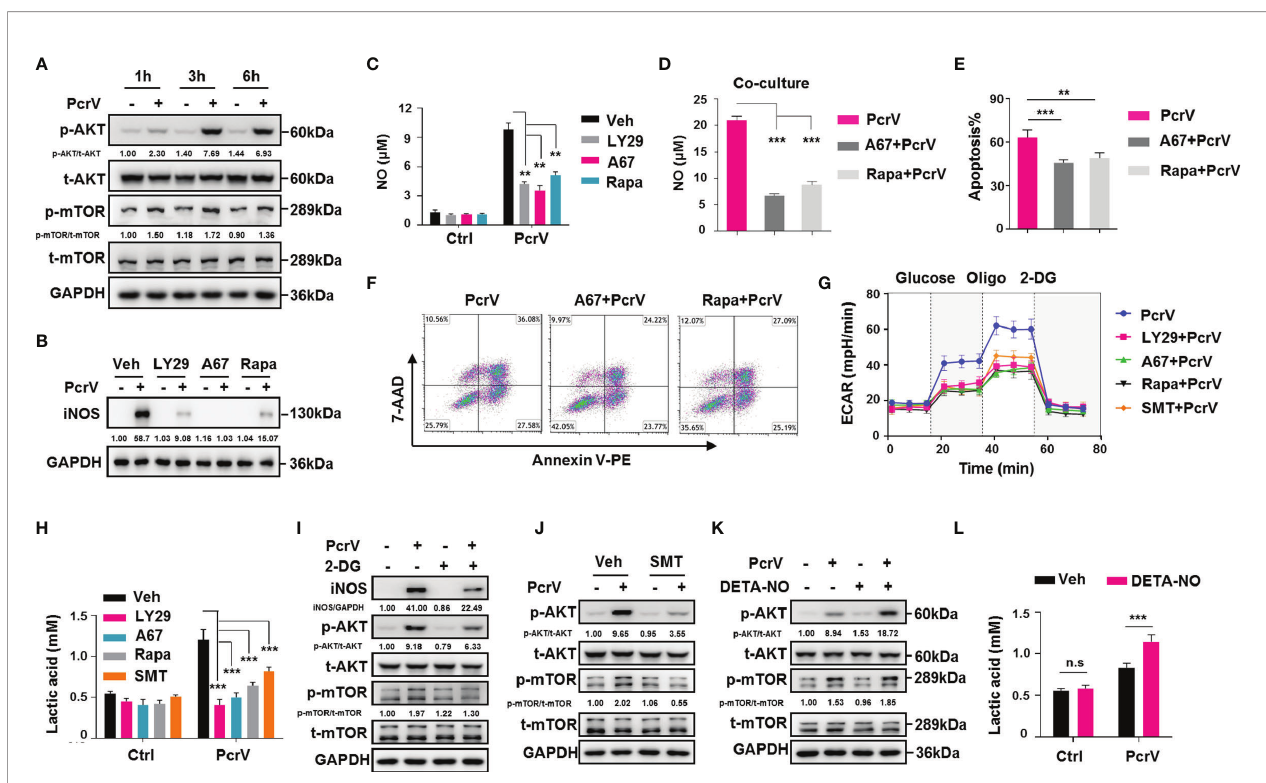
FIGURE 6 | PcrV-mediated activation of the PI3K/AKT/mTOR-glycolysis-NO feedback loop reeducates tumor-associated macrophage (TAMs) and enhances TAM- mediated cytotoxicity against cancer cells. For the inhibition of the PI3K/AKT/mTOR axis, TAMs were pretreated with a PI3K (LY294002, 20 m M), AKT (A674563, 1 m M), or mTOR (rapamycin, 50 m M) inhibitor for 1 h and then primed with PcrV (10 m g/ml) for the indicated times. (A, B) Protein levels were analyzed by Western blotting. (C) The nitric oxide (NO) level in the culture supernatant (24 h) was detected using Griess reagent. Bone marrow-derived macrophages (BMDMs) pretreated with AKT or mTOR for 1 h were primed with PcrV (10 m g/ml) for 24 h and then co-cultured with LLC cells for another 24 h (D) Detection of NO levels in the culture medium. (E, F) The apoptosis of LLC cells was detected by FACS. TAMs pretreated with the PI3K/AKT/mTOR inhibitors (1 h), S -methyl thiourea (SMT; 0.5 mM, 2 h), or 2-deoxy- D -glucose (2-DG; 2 mM, 2 h) were primed with PcrV (10 m g/ml) for another 24 h (G) Extracellular acidi fi cation rate (ECAR) measurement. (H) Measurement of lactic acid levels in the culture supernatant. (I, J) Protein levels were analyzed by Western blotting. For increasing the NO concentration, TAM culture medium was supplemented with DETA-NO (20 m M) in combination or not with PcrV (1 m g/ml) for 24 h (K) Protein levels were analyzed by Western blotting. (L) Measurement of lactic acid level in the culture supernatant. Data were expressed as means ± SD and analyzed by unpaired Student ’ s t -test. ** p < 0.01 and *** p < 0.001. Oligo, oligomycin; Veh, vehicle; LY29, LY294002; A67, A674563; Rapa, rapamycin; LLC, Lewis lung cancer; FACS, fl uorescence-activated cell